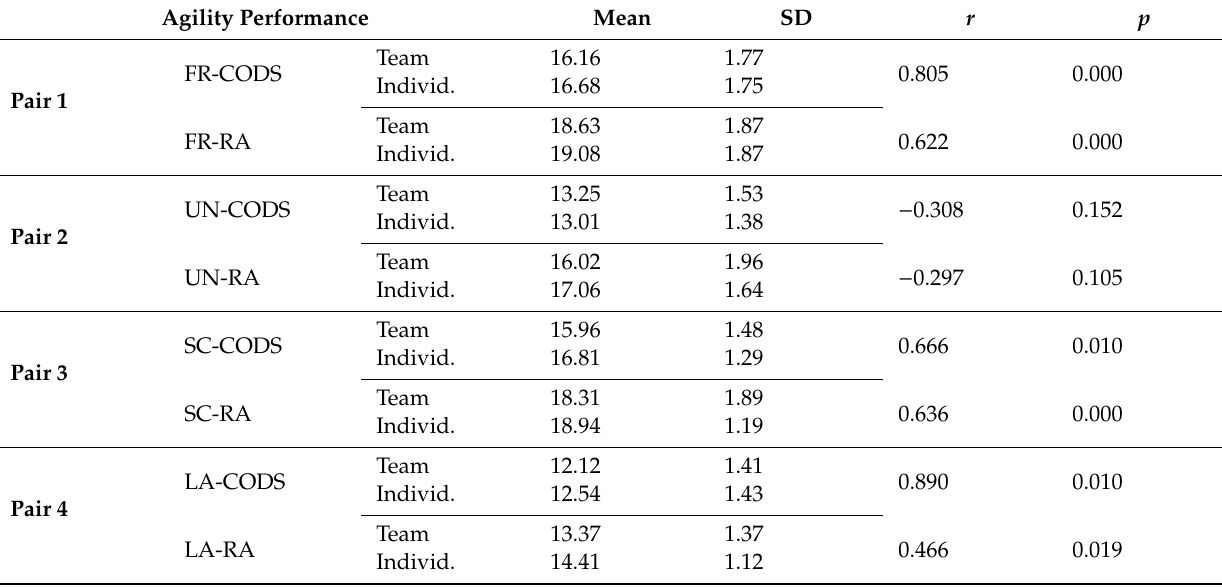
Table 5. Within-group correlations of change-of-direction speed (CODS) and reactive agility (RA) performance in) di ff erent configurations. Agility Performance Mean SD p